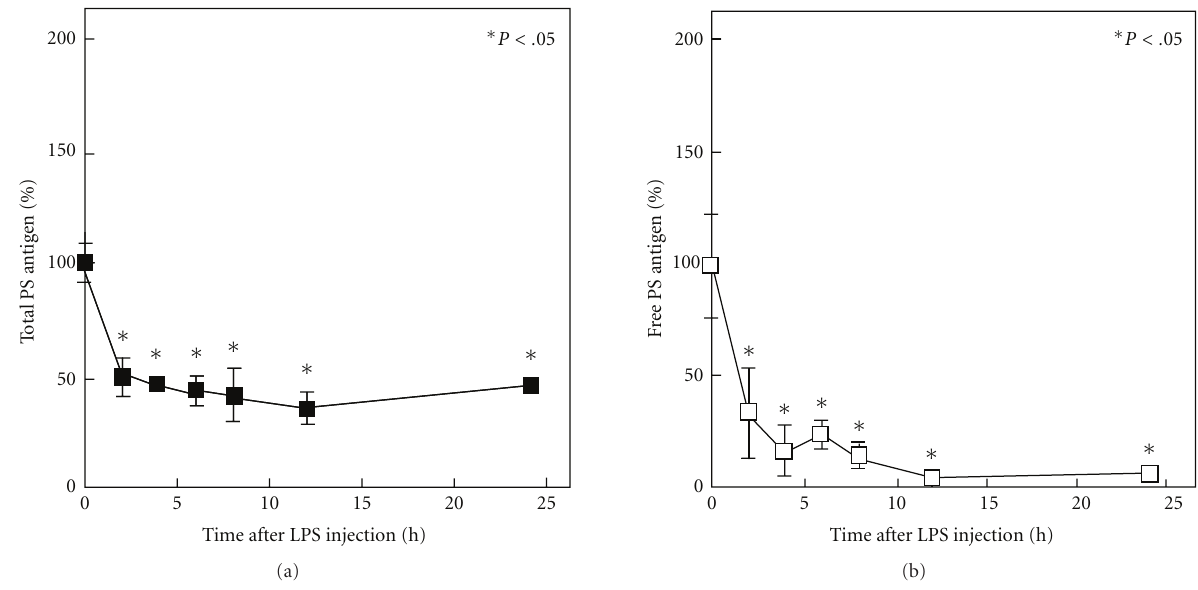
Figure 3: Changes in plasma levels of total PS and free PS in LPS-treated rats . Citrated plasma was obtained from three rats treated with LPS intraperitoneally (2mg · kg − 1 ) at each time point to determine (a) plasma total PS antigen levels and (b) plasma free PS antigen levels, as described previously in [31]. Data are expressed as the mean ± S.D. ( n = 3). ∗ P < . 05 versus time